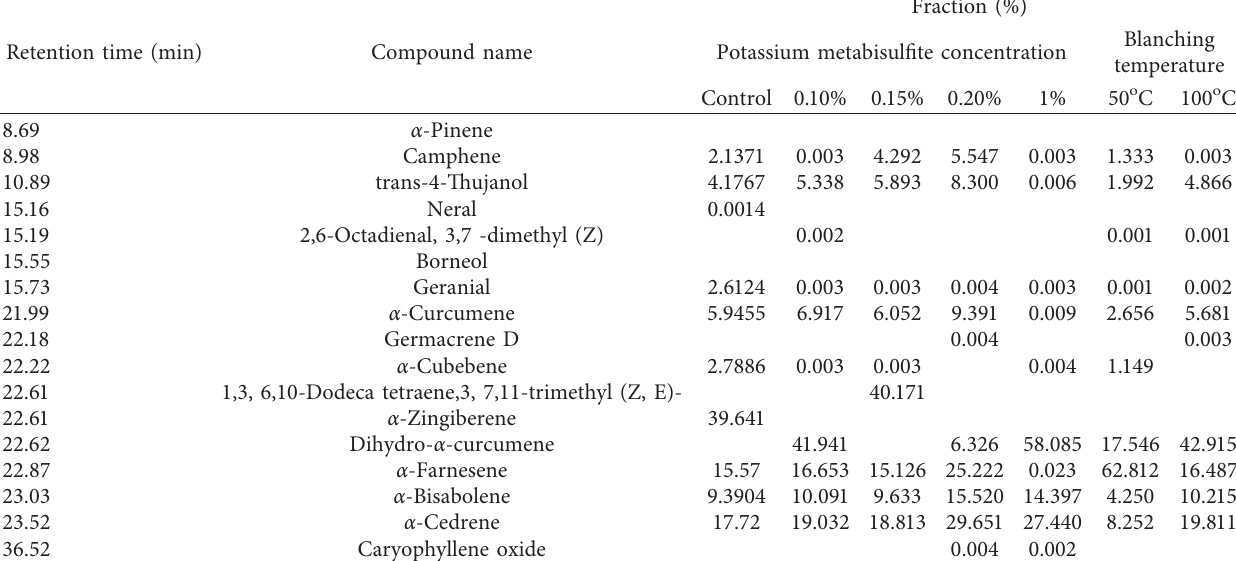
Table 1, but the solar dried and open-sun-dried samples showed differences in the top 5 compounds detected. In the CSD samples, compounds detected were dihydro- α -curcu- mene (39.72%), α -farnesene (15.54%), β -bisabolene (9.69%), α -curcumene (5.94%), and β -phellandrene (4.34%) as shown in Table 2.